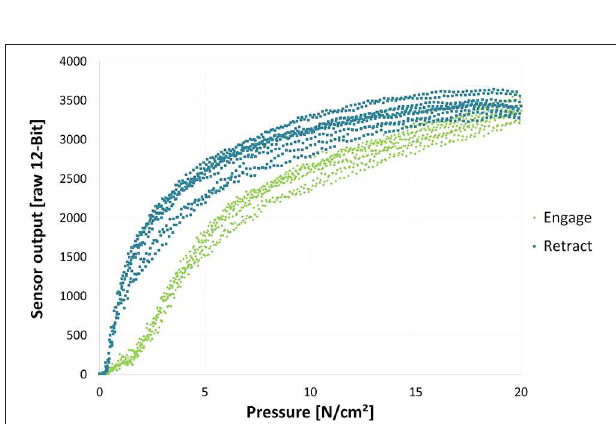
FIGURE 1 | The second generation tactile bracelet: (left) the bracelet and a single sensor module in the upper left; (right) three communication modules — USB, Bluetooth and Wi-Fi. The wireless modules include the circuitry for battery charging, powered through a dedicated USB connection.